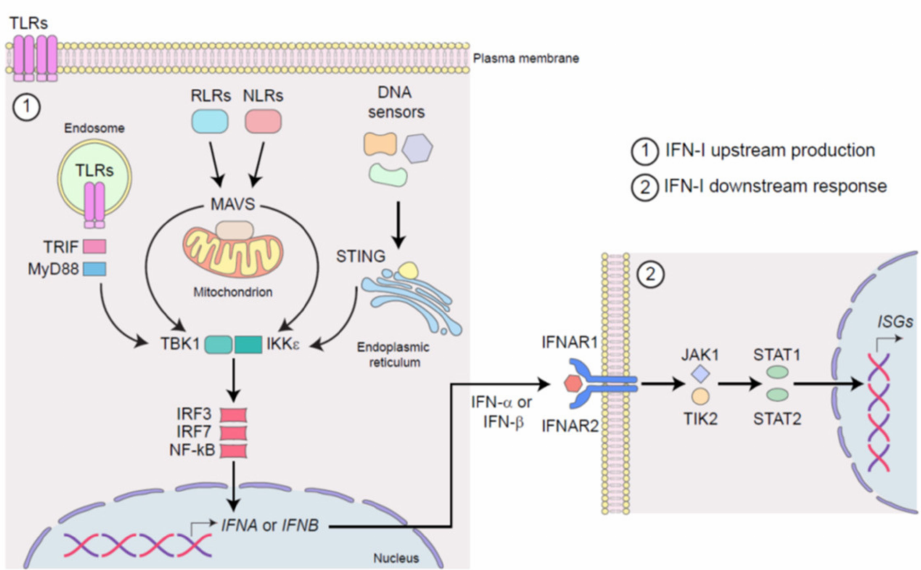
Figure 1. Schematic representation of IFN-I signaling in infection and cancer. ( 1 ) The stimulation of surface, cytosolic, and endosomal pattern recognition receptors (PRRs), by pathogen-associated molecular patterns (PAMPs) during infection or by damage-associated molecular patterns (DAMPs) in cancer, induces IFN-I production. Upon activation, Toll-like receptors (TLRs) signals through TRIF and MyD88, RIG-I-like receptor (RLRs) and NOD-like receptors (NLRs) through MAVS, whereas DNA sensors engage STING. All of these adaptor molecules activate IKK ε /TBK1 kinase complex, which in turn triggers the activation of transcription factors IRF3/7 and NF- κ B, leading to the production of IFN- α and IFN- β . ( 2 ) Once released from infected or cancerous cells, IFN- α and IFN- β act in an autocrine, paracrine, and systemic manner by binding the heterodimeric receptor IFNAR1-2, which in turn activates JAK/STAT pathway leading to the transcription of multiple IFN-stimulated genes